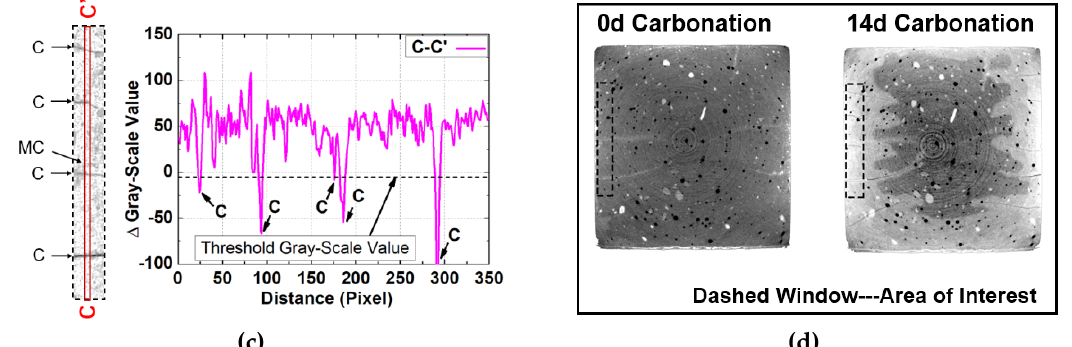
Figure 7. Method for crack detection: ( a , b ) represent the identical local areas at 0 and 14 days of carbonation, respectively, and AA’ and BB’ represent 1D grayscale value profiles obtained through linear scanning of the identical area on a and b, respectively; ( c ) represents the local area and 1D profile from ( b ) minus ( a ); and ( d ) represents the cross-sectional area at 0 and 14 days of carbonation, respectively, and the dashed windows represent the local area adopted for investigation.